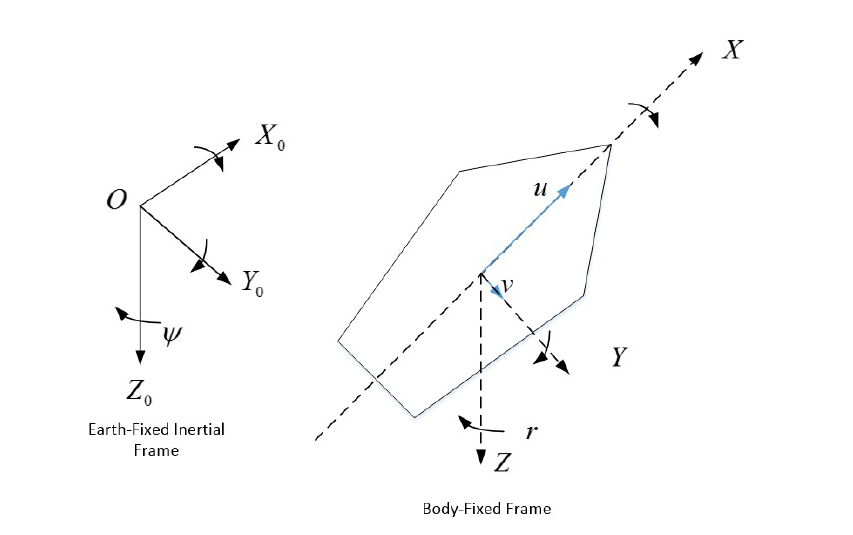
Figure 1. The Earth-fixed inertial and body-fixed